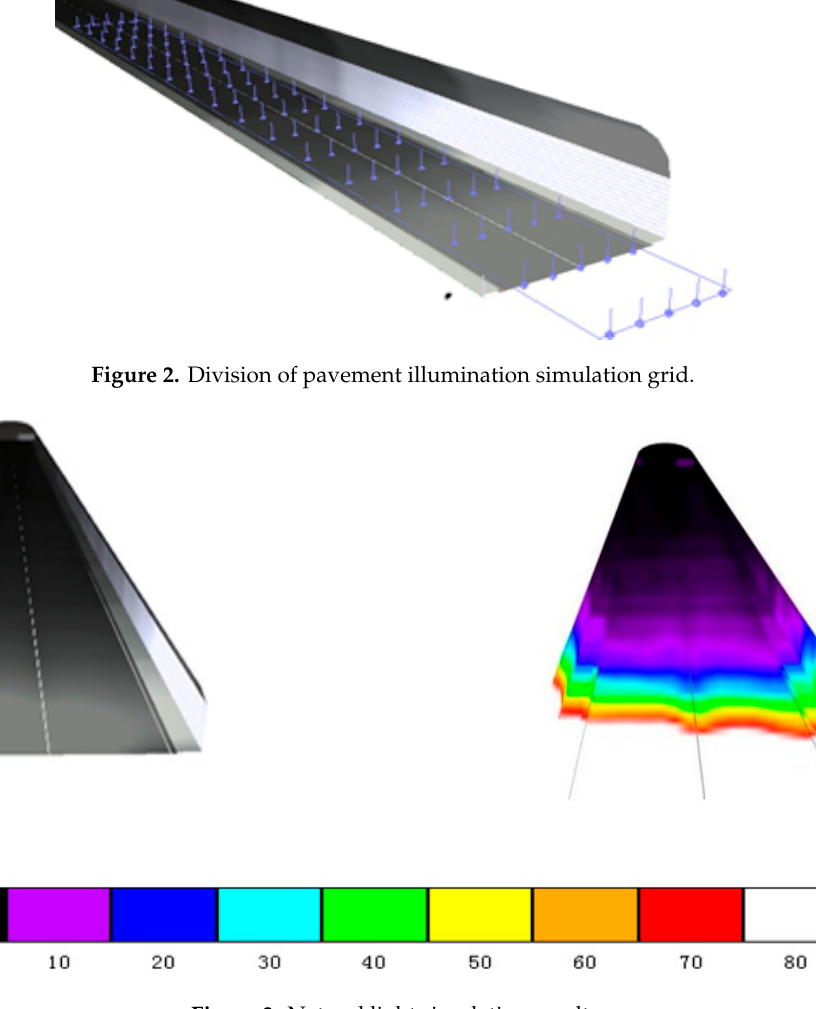
Figure 3. Natural light simulation result.